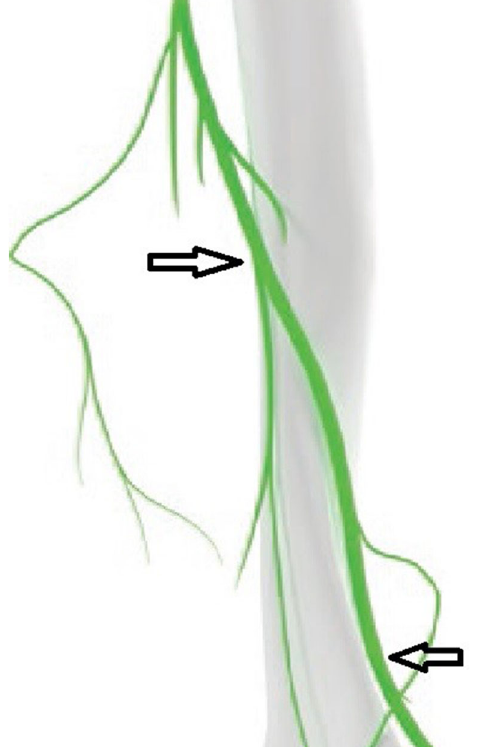
Fig. 1 Black arrows denote the site where the radial nerve is easily identified in its short axis: in the spiral groove and distally between the brachialis and brachioradialis.